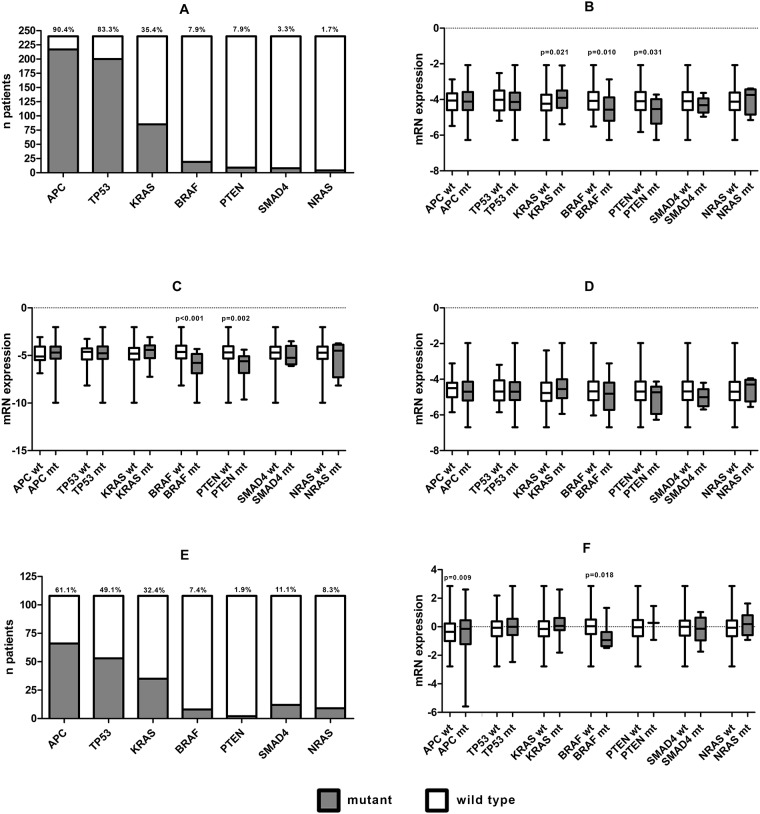
The association between SYK mRNA expression and known CRC mutations.Mutation rates in the MATCH cohort (n = 240)(a); differences in mRNA expression of SYK(T) (b), SYK(S) (c) and SYK(L) in the MATCH cohort; mutation rates in the TCGA (n = 108)(e); differences in mRNA expression of SYK(T) in the TCGA cohort (f).